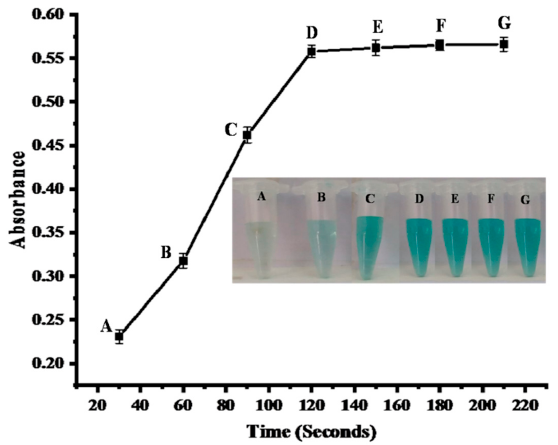
Figure 8. Time optimization. Time = (30–210 s); the best response was at 120 s. Capped amount of Co/CeO 2 /C/IL = 50 µL, TMB = 180 µL (10 mM), PBS = 500 µL of pH 7.0, H 2 O 2 85 µL (6 mM). The absorbance was measured in the range of 200–800 nm.